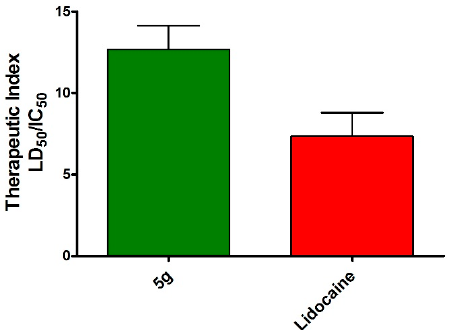
Figure 2. Acute toxicity of (ip) of lidocaine and compound 5g in male mice.